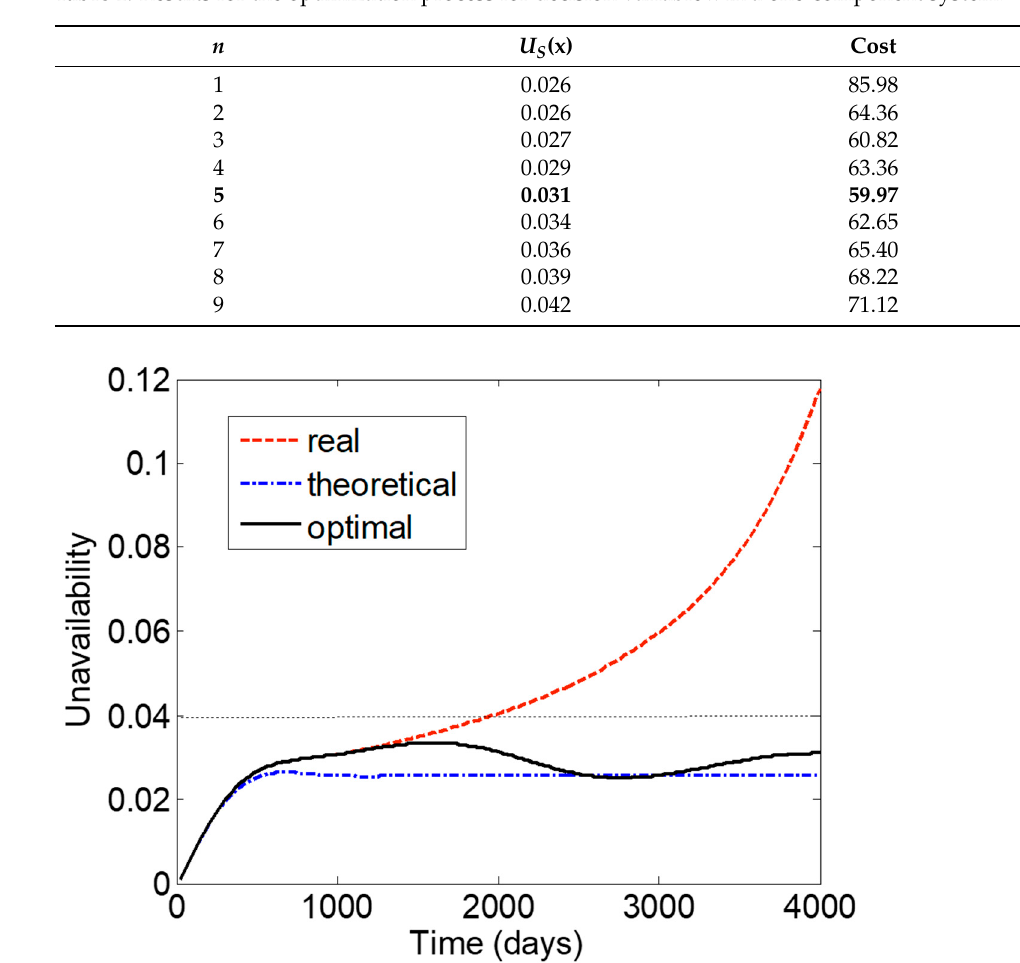
Table 1. Results for the optimization process for decision variable n in a one-component system.